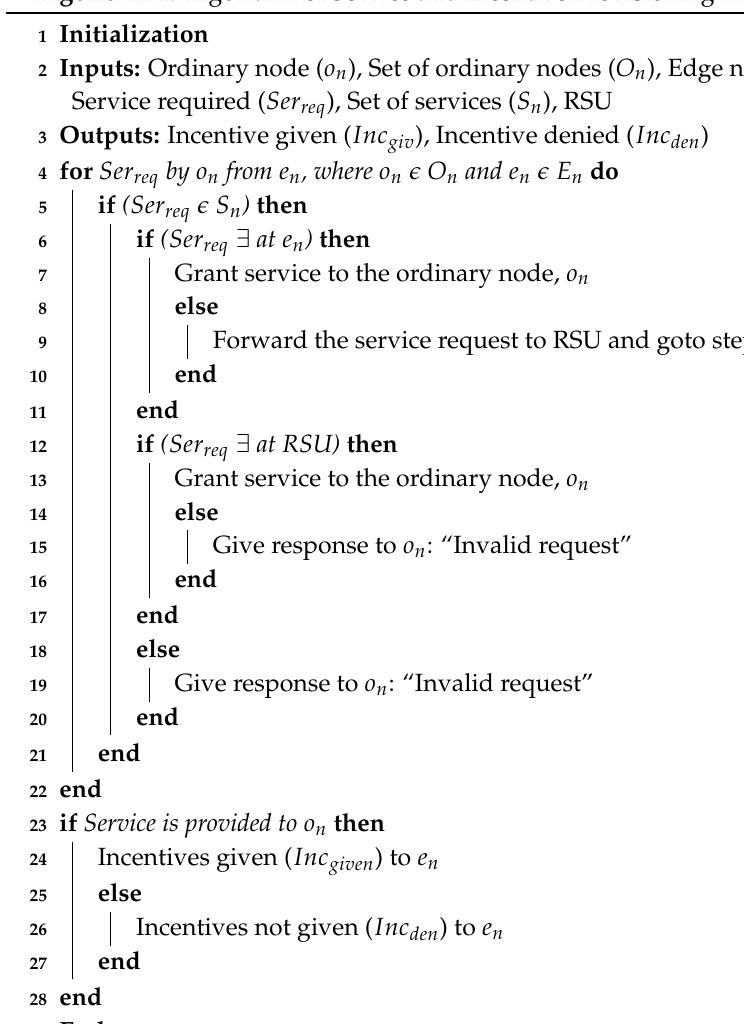
Algorithm 1: Algorithm of Service and Incentive Provisioning in VN. 1